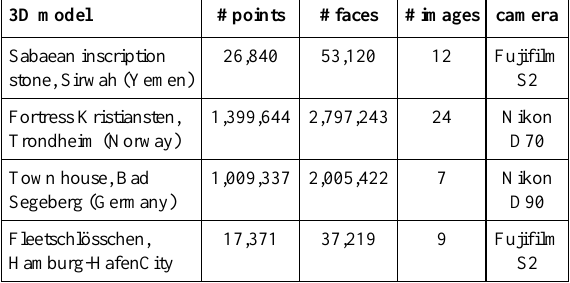
Figure 7. Result of automatic texture mapping for the 3D model of the Sabaean inscription stone at the Almaqah temple in Sirwah